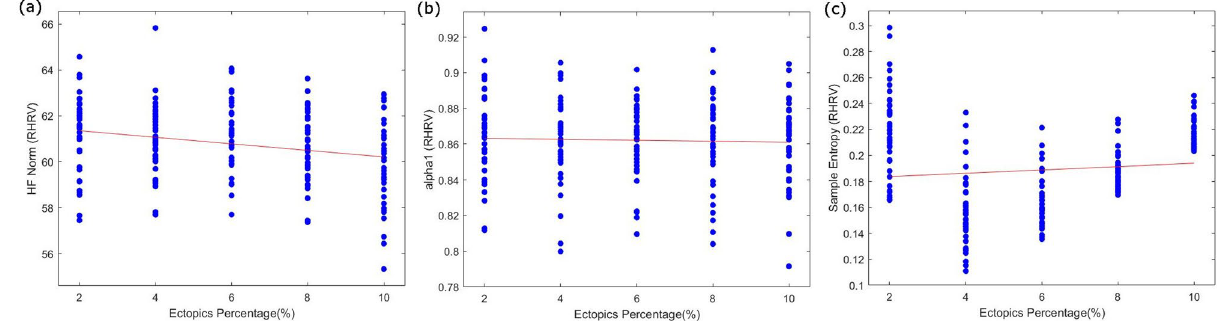
Figure 7. Examples of HRV measures that did not show a linear relationship in the relative change of HRV measure (y axis) with an increasing percentage of ectopic noise (x axis), ( a ) HF-Norm, ( b ) alpha 1, ( c ) Sample